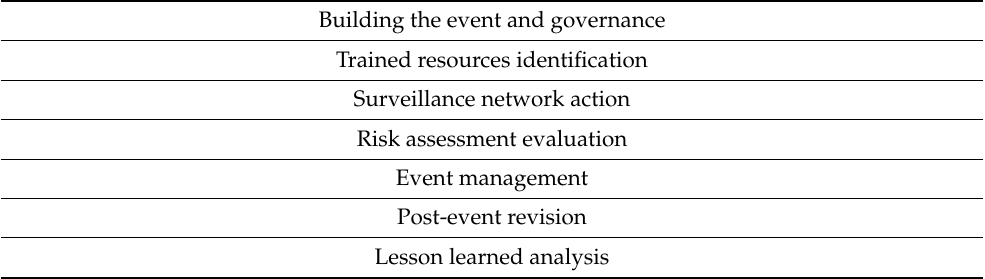
Table 1. Headache preparedness